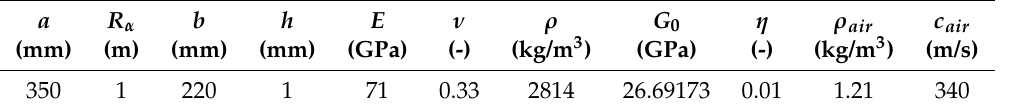
Table 1. Geometrical and material data for the simple cylindrical